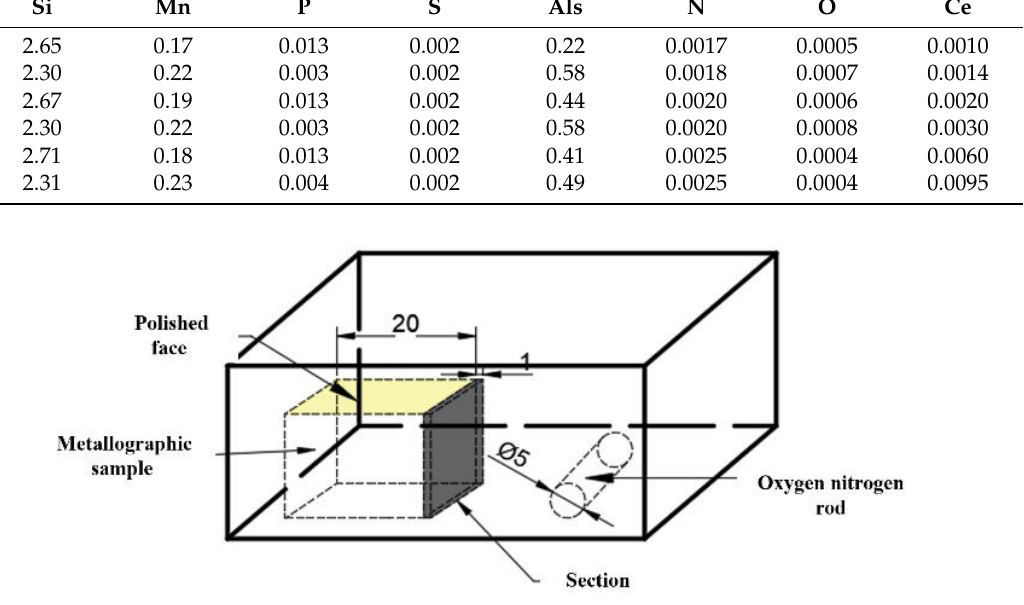
Figure 1. Sampling diagram of the experimental steel.